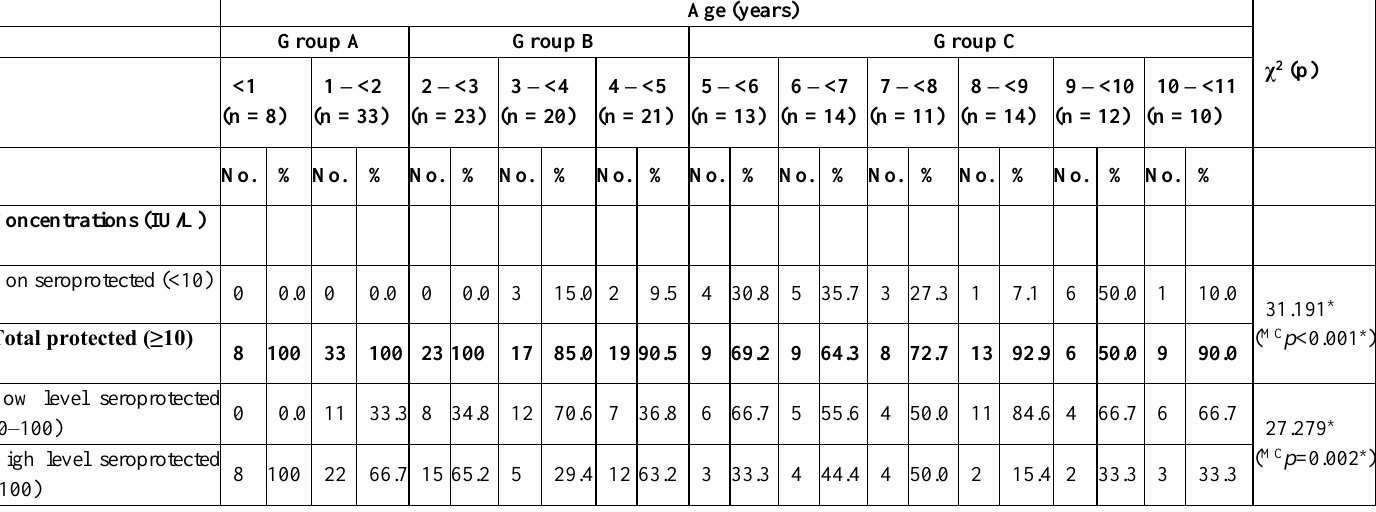
Table 3. Relation between seroprotection rate & levels of seroprotection (IU/L) in different age categories.